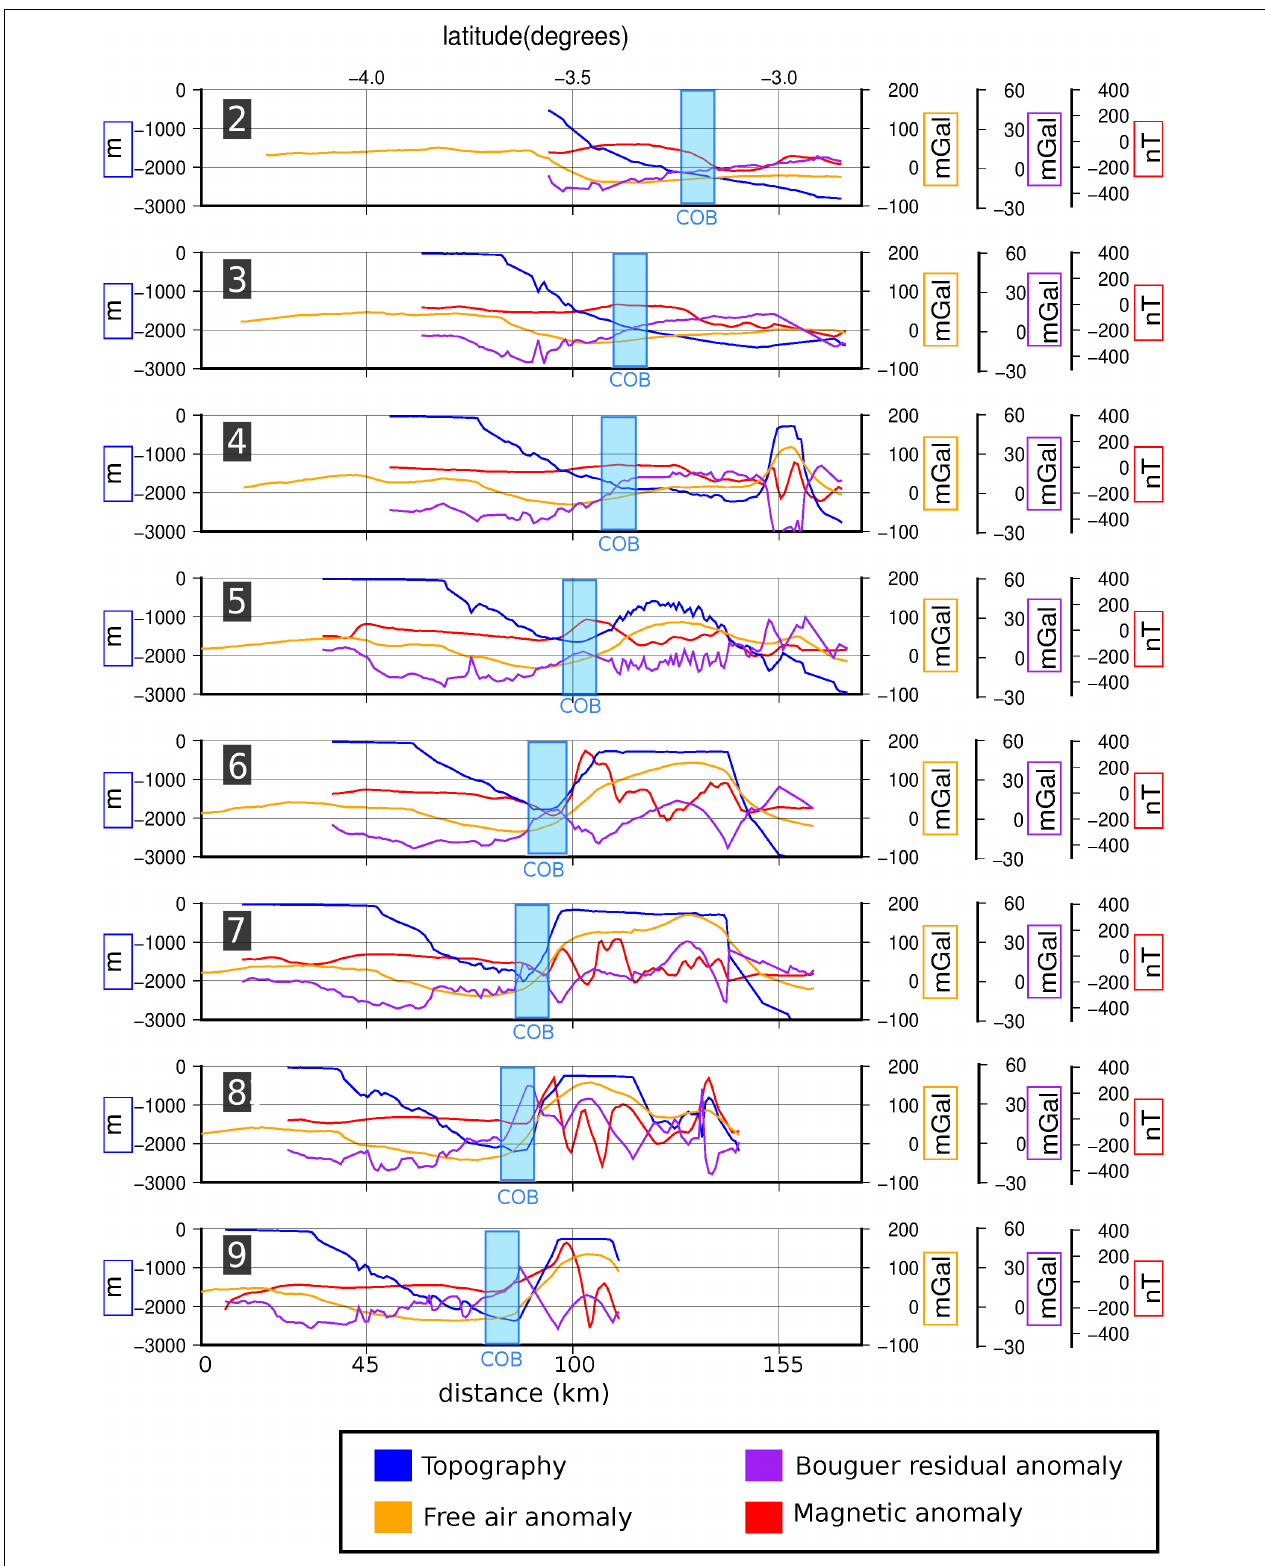
FIGURE 4 | Profiles 2, 3, 4, 5, 6, 7, 8, and 9 from Equant I with the COB position (blue rectangles).